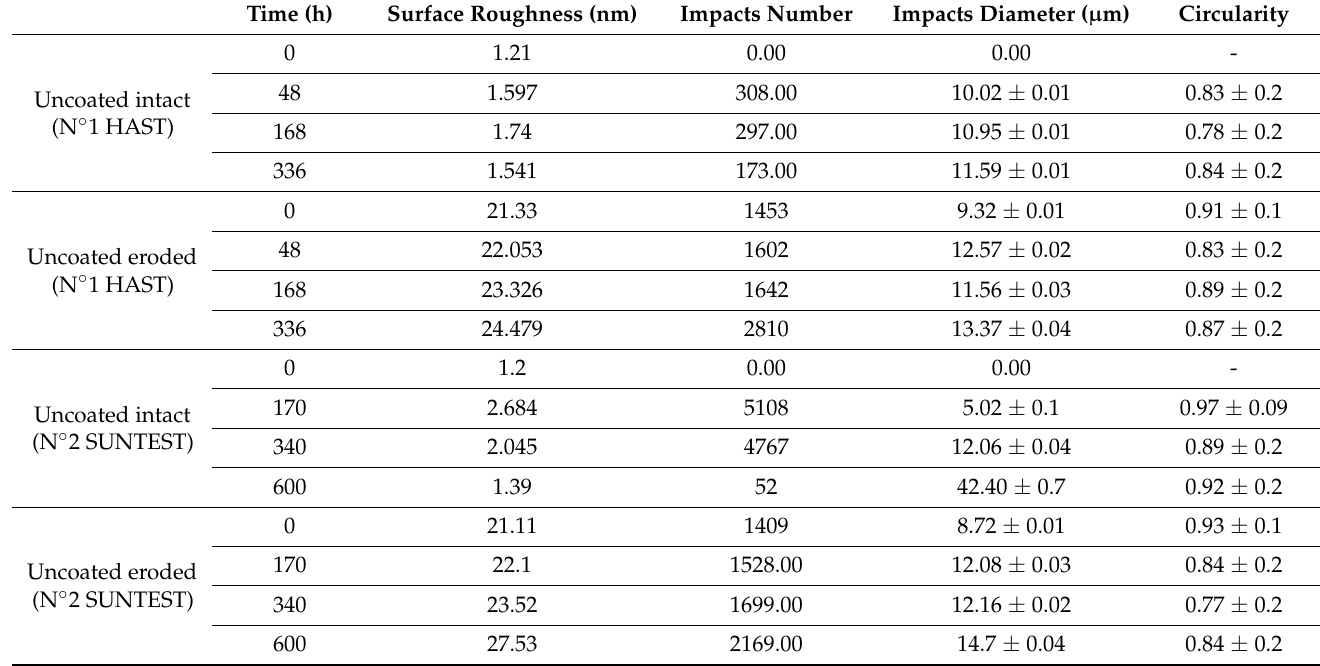
Table 3. Impacts properties and surface roughness of uncoated samples.